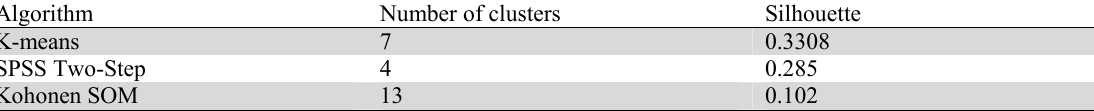
Comparison of the clustering algorithms for scenario 1 in situation 1 Algorithm